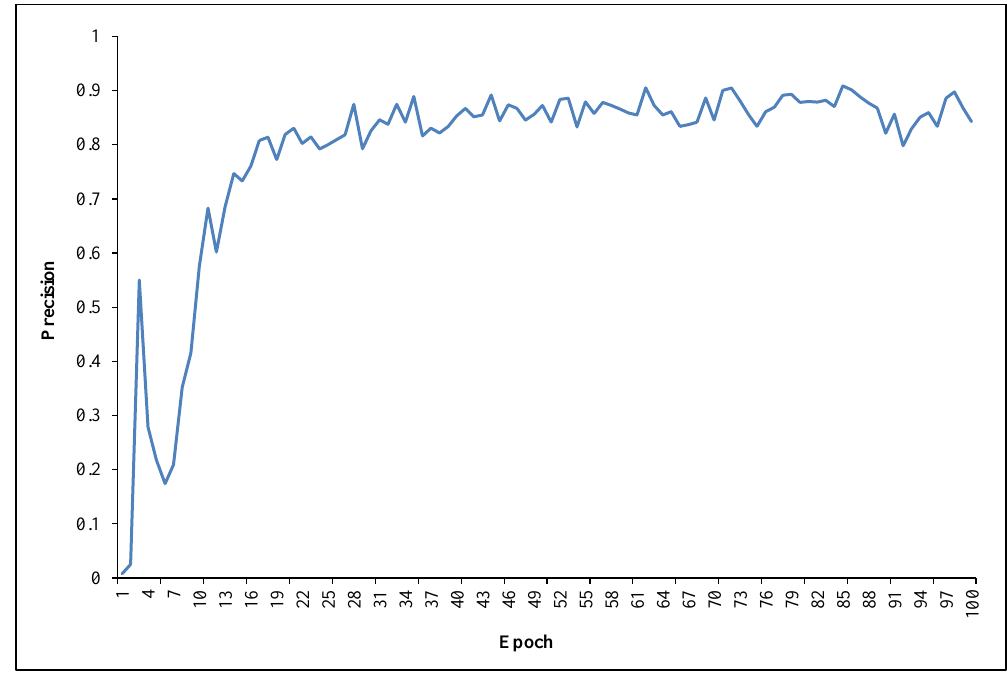
Figure 5. Yolov5s model precision vs epochs